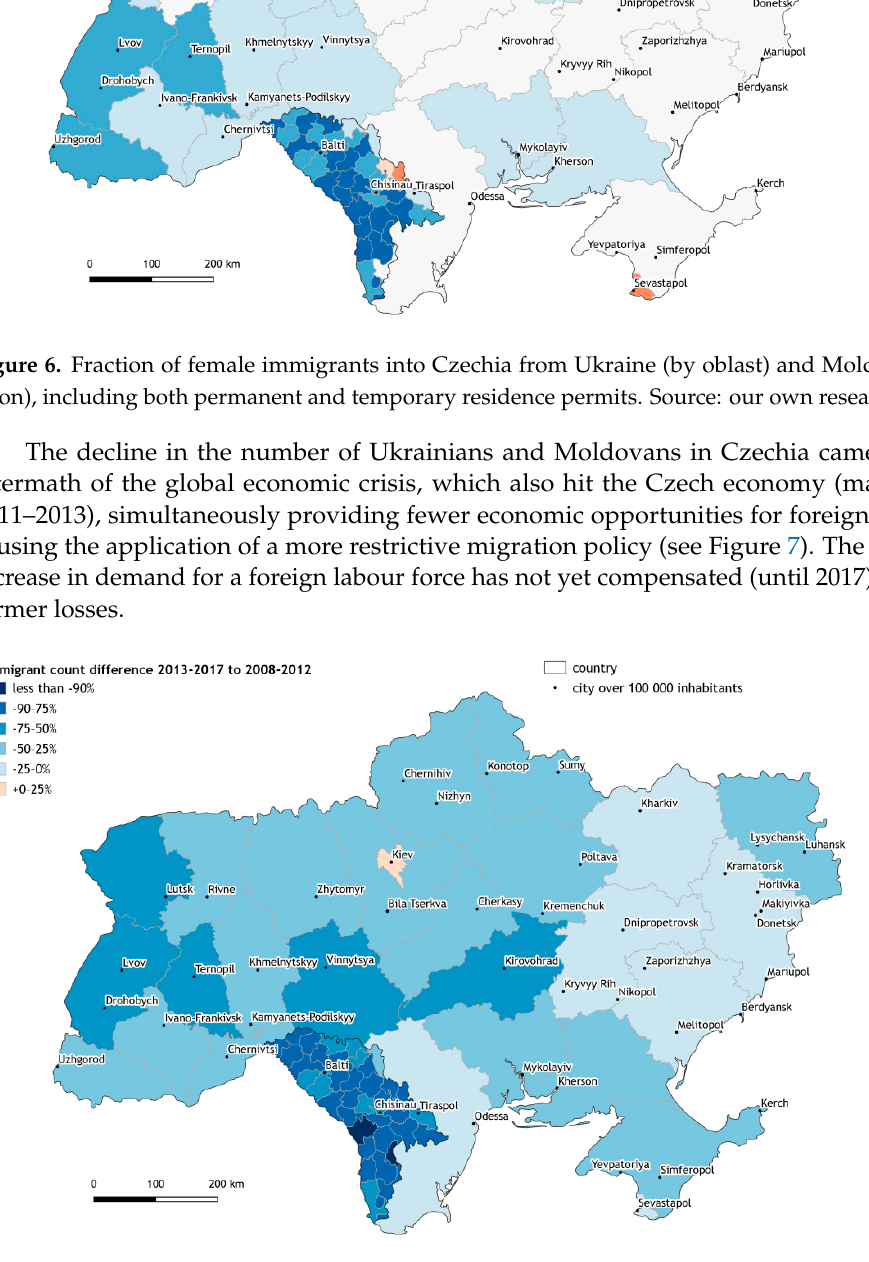
Figure 7. Difference in the count of migrants into Czechia from Ukraine (by oblast) and Moldova permits. Source: our own (by raion) in 2013–2017 compared to 2008–2012, including both permanent and temporary resi- dence permits. Source: our own research.